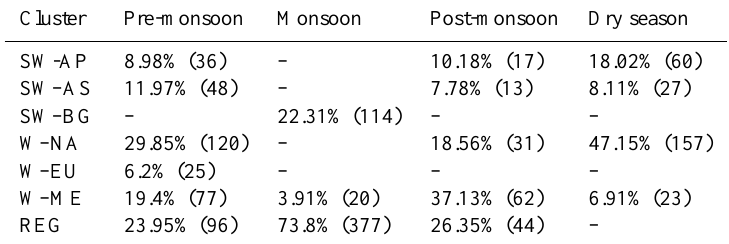
Table 3. Seasonal cluster frequency and number (in parenthesis). See text for the air mass origin type description.